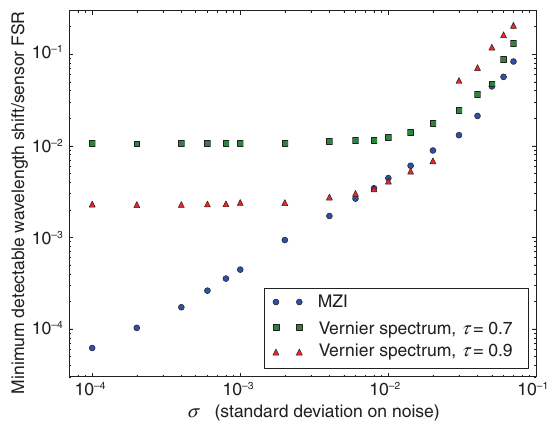
Figure 7: Minimum detectable wavelength shift for the MZI(circles) and the Vernier with self-coupling coefficients 0.7 (squares) and 0.9 (triangles) when noise is